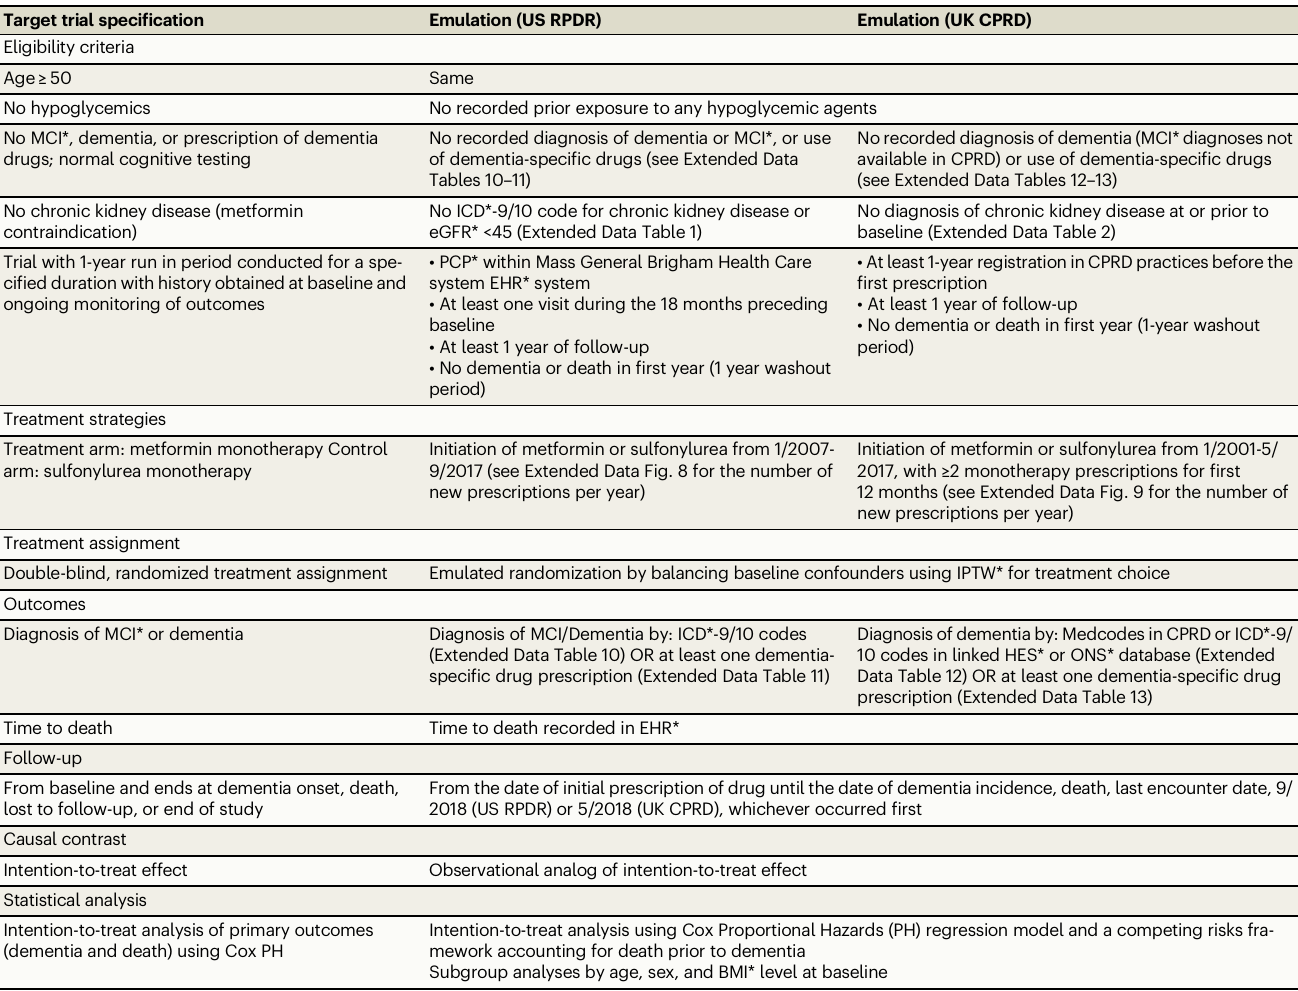
Table 1 | Speci fi cation and emulation of a target trial of antidiabetic drug metformin vs. sulfonylureas on the risk of death and dementia, using observational data from Electronic Health Records of the US RPDR and the UK CPRD Target trial speci fi